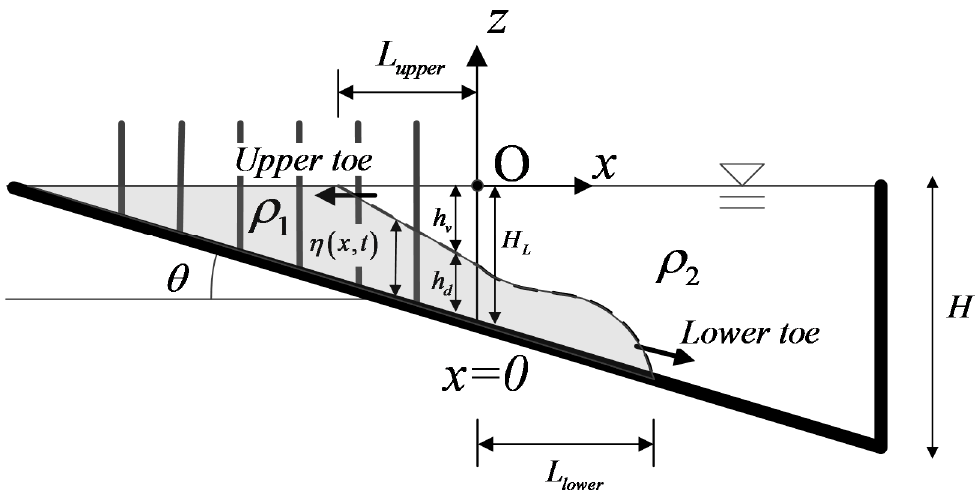
Figure 1. Schematic of a lock-exchange experiment with a model canopy distributed in a shallow region. The maximum water depth is H , and the lock is positioned at x = 0, i.e., the center of the tank, with a water depth of H L . η ( x , t ) is the interface between two different fluid densities, and L lower and L upper are the horizontal distances of the interfaces from the lock in the lower and upper layers, respectively. ρ 1 and ρ 2 are the densities of heavier and lighter fluids, respectively. If the current motion is over a flat bottom, i.e., (cid:1845) (cid:2868) = 0 , (cid:1873) (cid:3049) becomes the result derived by Tanino